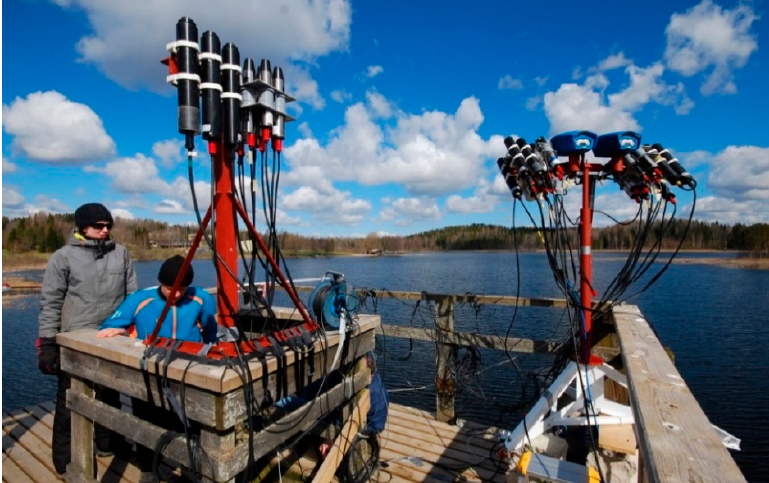
Figure 3. 3D CAD (computer-aided design) drawings of the frames for mounting irradiance (left) and radiance (right) sensors during the outdoor experiment.